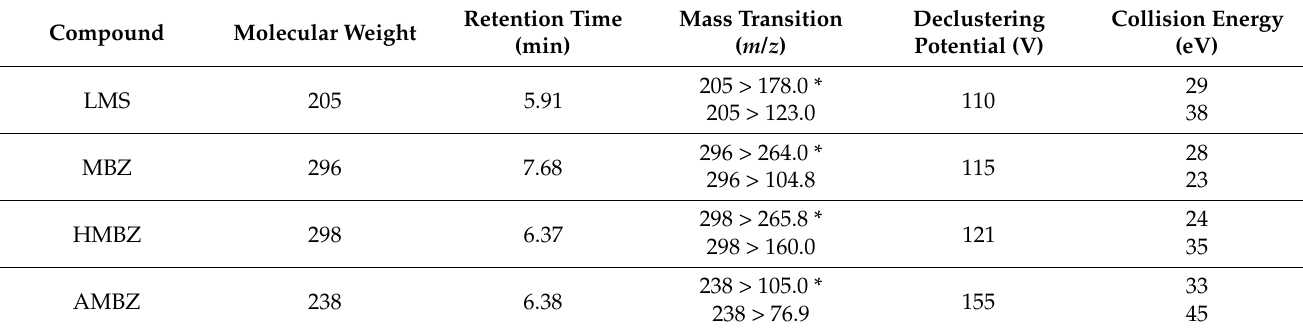
Table 1. HPLC-MS/MS conditions and retention times for the analysis of LMS, MBZ, HMBZ and AMBZ.